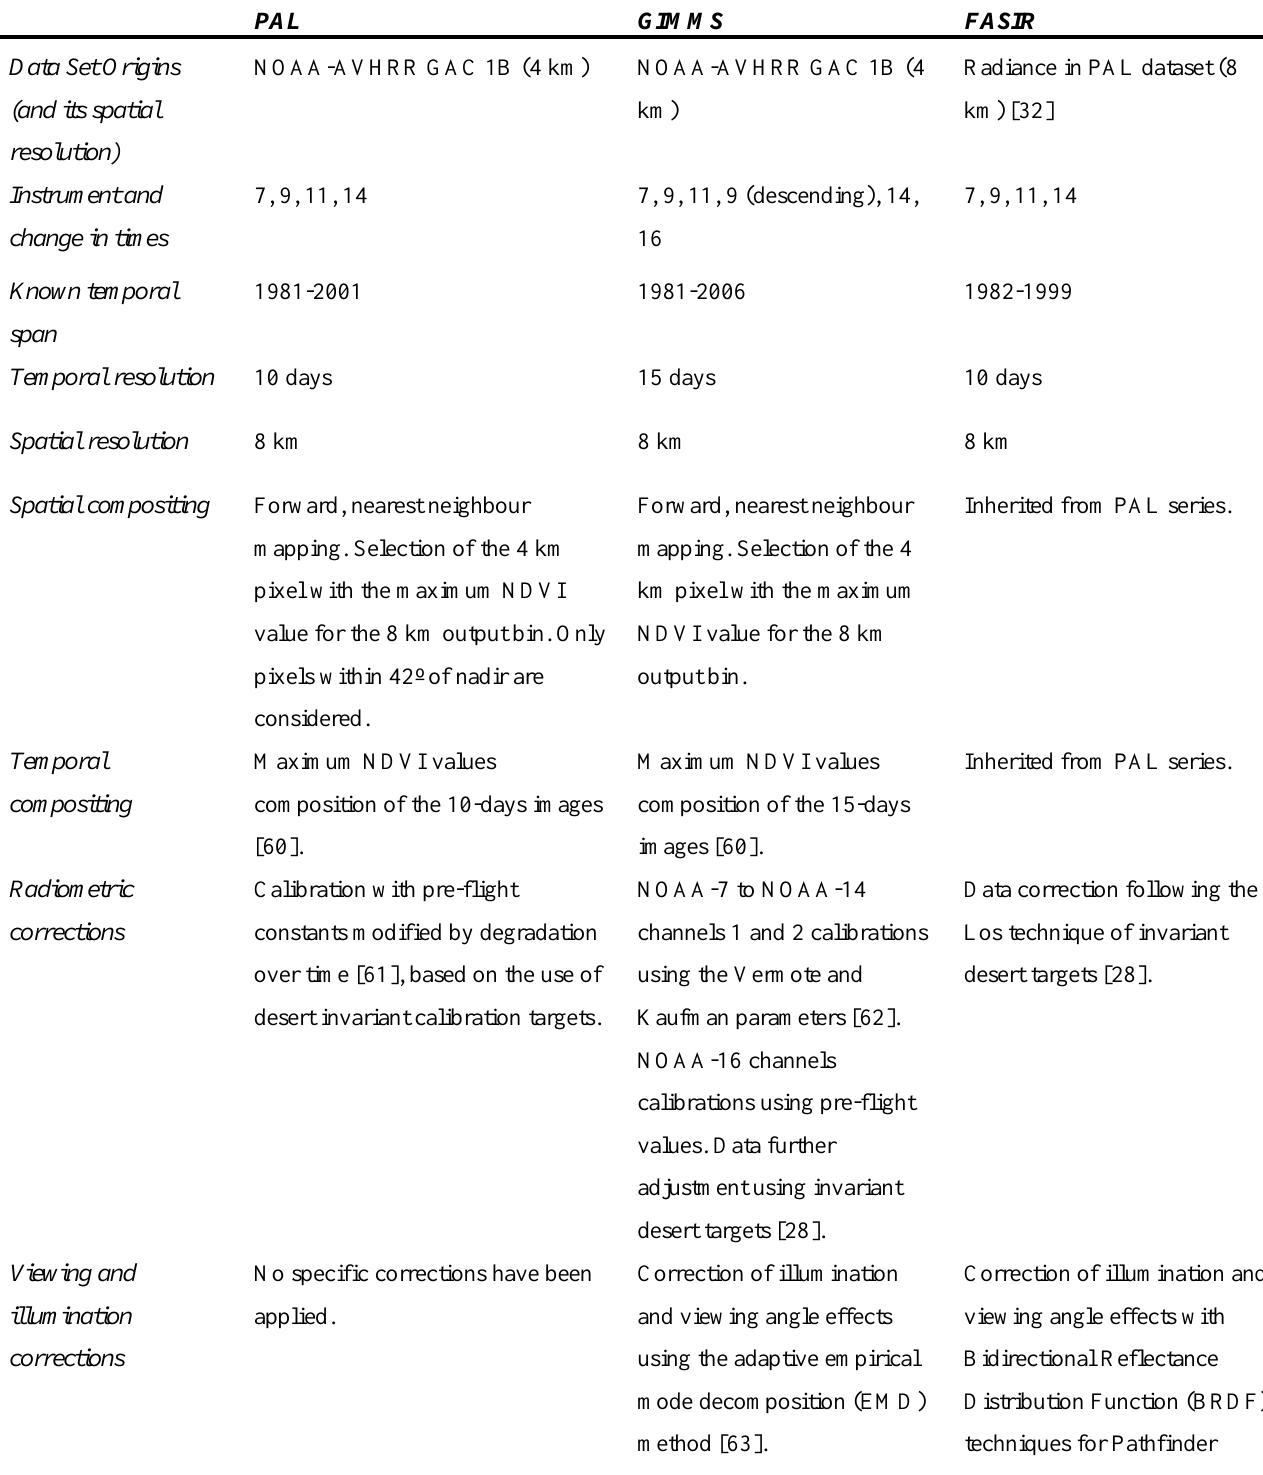
Table 1. Description of the three NDVI NOAA-AVHRR data sets used in this study [adapted from 27, 30, 31, 34, Los personal communication, updated version of 36, 64, 69,